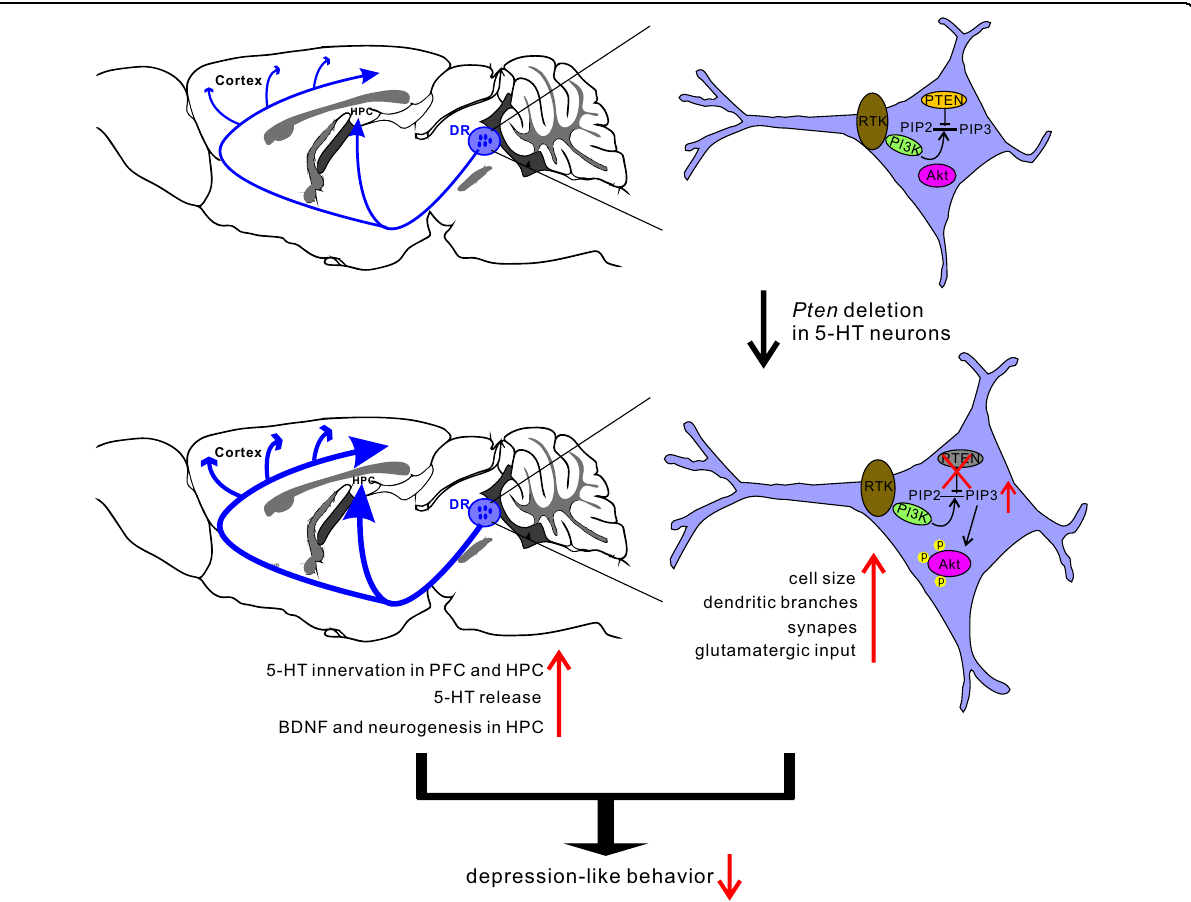
Fig. 6 Schematic diagram demonstrating the effect of Pten deletion in 5-HT neurons. Environmental factors such as chronic stress upregulate PTEN expression in central 5-HT neurons and reduce its functions leading to the onset of depression. Conversely, deletion of Pten gene or reducing its expression in the 5-HT neurons may restore its functional and structural plasticity and display antidepressant effects, possibly via enhancing adult neurogenesis and BDNF levels in the